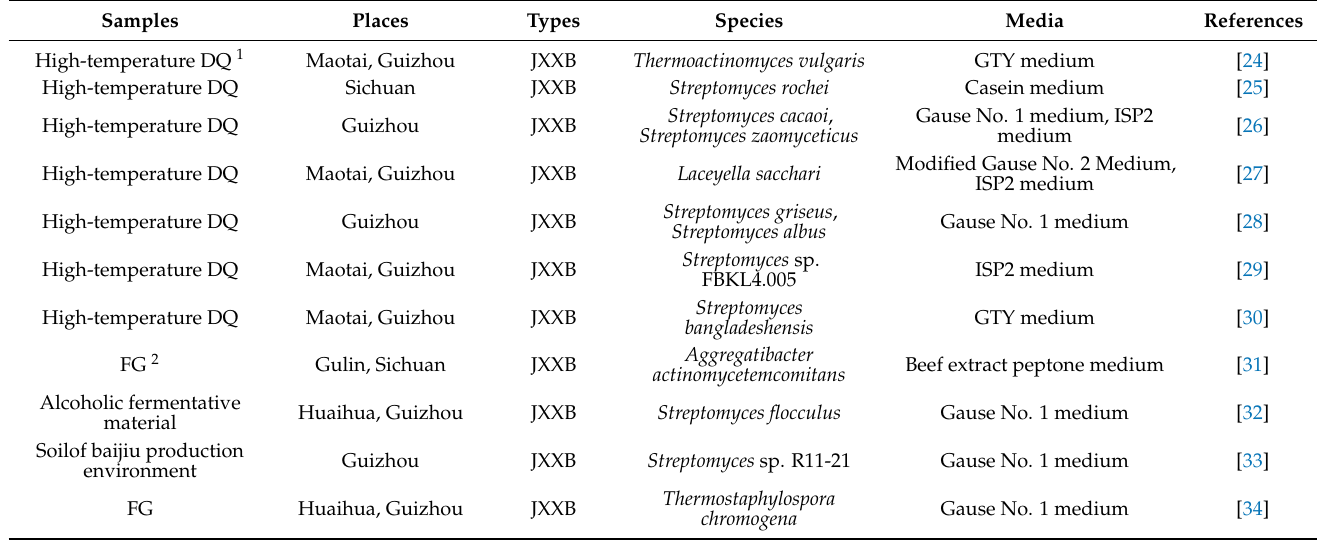
Table 1. Actinomycete species isolated and identified from